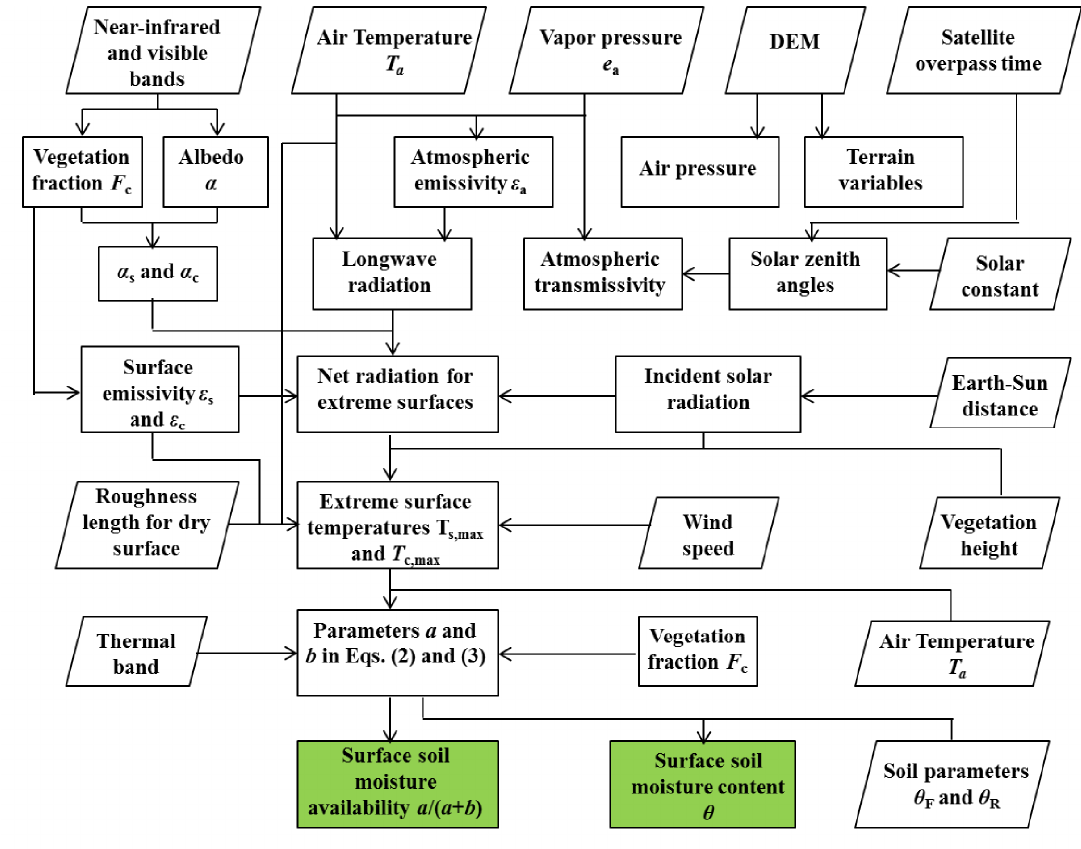
Figure 2. Flow chart of the trapezoidal model for estimating surface soil moisture (SM). Trapezoids represent input variables or parameters, and rectangles represent intermediate variables or